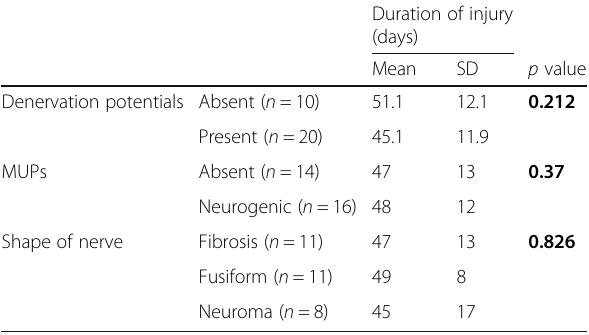
Table 5 Correlation between duration of injury and denervation potentials, morphology of MUPs, and shape of the injured nerve by ultrasound